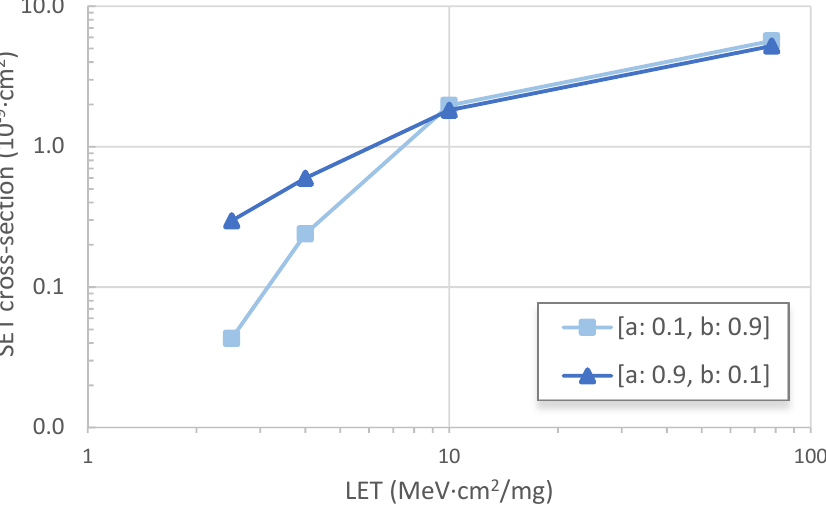
Figure 9. SET cross-section curves for the 2-input NOR gate considering two signal probability scenarios: Lowest signal probability assigned to input pin a [ a :0.1, b :0.9]; lowest signal probability assigned to input pin b [ a :0.9, b :0.1].